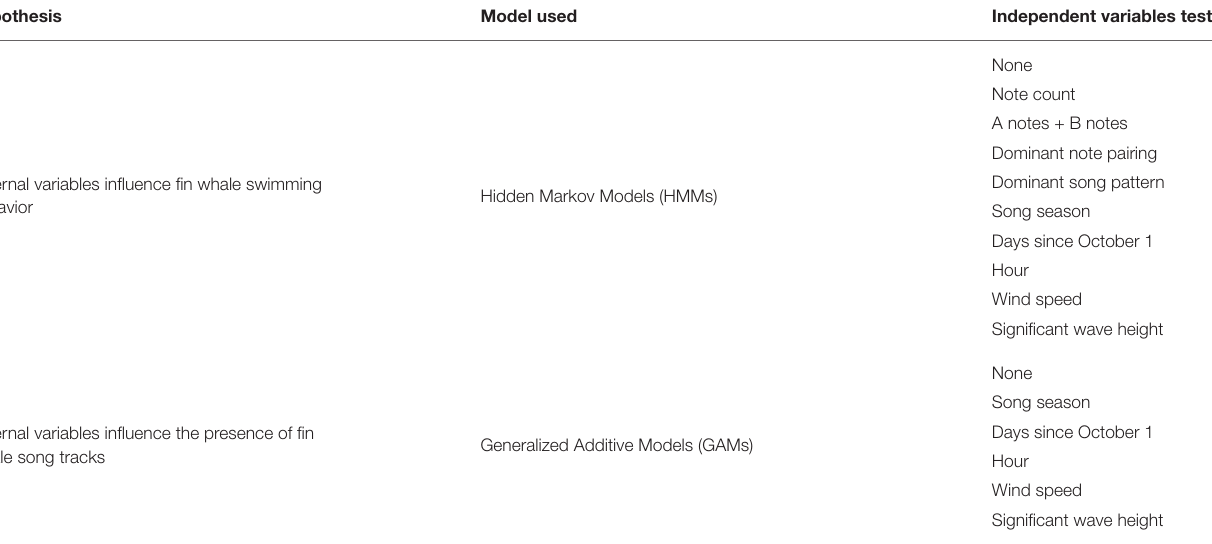
TABLE 1 | Summary of the hypotheses tested, the models used for each type of test, and the independent variables tested.